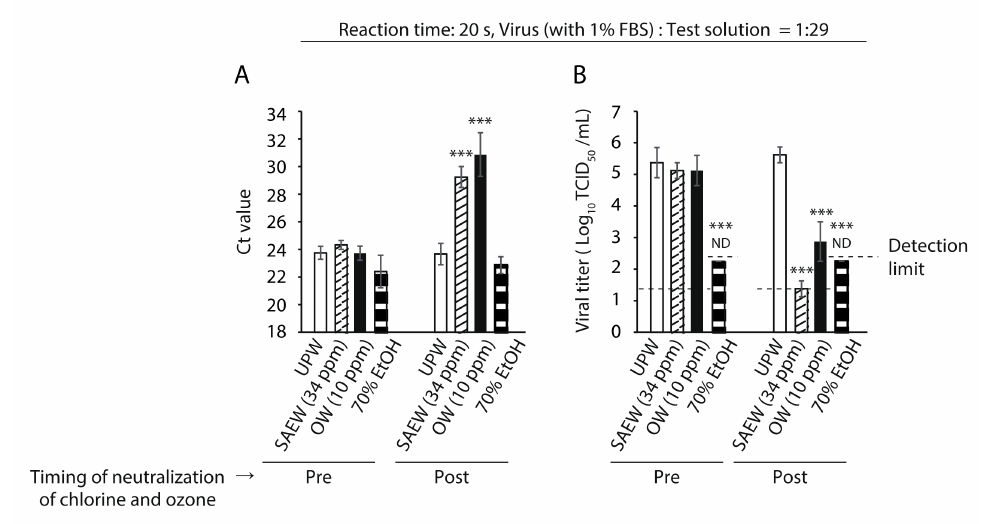
Figure 3. Evaluation of the impact of test solutions on the SARS-CoV-2 genome. ( A ) The cycle threshold (Ct) value of each reaction mixture was measured. ( B ) The viral titer of each reaction mixture was measured. The detection limits of the viral titer are 1.25 log 10 50% tissue culture infective dose (TCID 50 )/mL in the ultra-pure water (UPW), slightly acidic electrolyzed water (SAEW) and ozonated water (OW) groups, and 2.25 log 10 TCID 50 /mL in the 70% ethanol (EtOH) group. ND is the abbreviation for not detected, which means that the viral titer was below the detection limit. (A, B) Results are indicated as mean ± standard deviation ( n = 4 per group). Student’s t -test was performed to analyze the statistical significance between the UPW (control) group and each test solution group; *** p < 0.001. Pre indicates that Na 2 S 2 O 3 was added to each test solution before mixing with the virus solution; Post indicates that Na 2 S 2 O 3 was added 20 s after mixing with the virus solution. FBS, fetal bovine